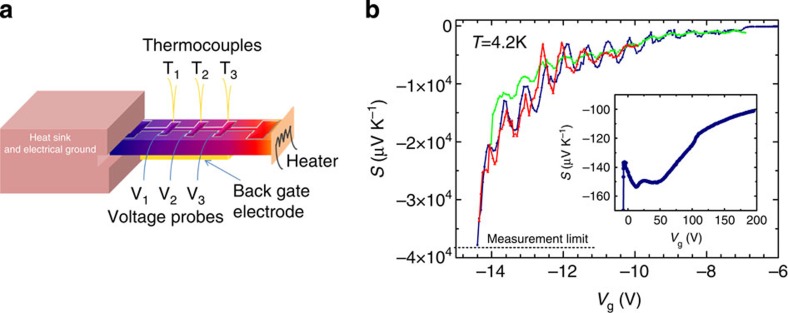
Seebeck measurement configuration and behaviour under gate field of a LAO/STO interface.(a) Sketch of the sample and experimental configuration for the Seebeck measurements: the two-dimensional electron liquid lies in the (001) plane of the SrTiO3, whereas the thermal gradient is applied along the 010 direction. (b) Seebeck coefficient versus gate voltage measured in a LAO/STO interface at 4.2 K. In the main panel, the different traces correspond to different thermal and Vg cycles: the red curve is measured using an ac heat flow whose power is 3.5 times smaller than the one (~mW) used for the blue and green curves. The blue and red curves are measured with decreasing gate voltage, whereas the green curve is measured with increasing gate voltage. The measurement limit related to the finite input impedance of the instruments used for the measurement of the voltage is also indicated. In the inset, a blow-up of the accumulation regime (Vg>0) is shown.